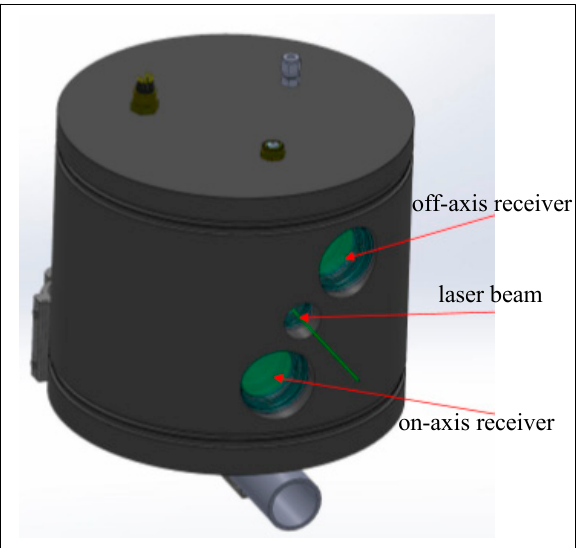
Figure 1. The Oculus system. The laser beam at each wavelength has the same origin.